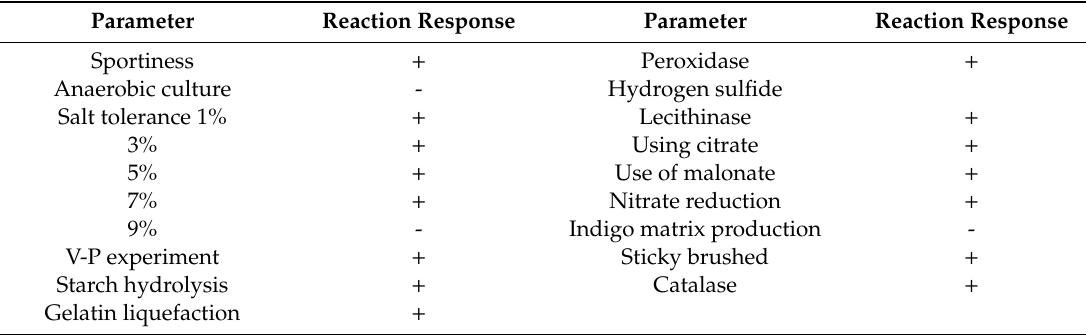
Figure 1. ( A ) Milk screening medium at 37 °C for 48 h; ( B ) Microscopic morphology of bacterial isolate cultured in LB liquid medium at 37 °C , 150 rpm for 24 h. Table 1. Physiological and biochemical identification tests to identify B. subtilis natto.